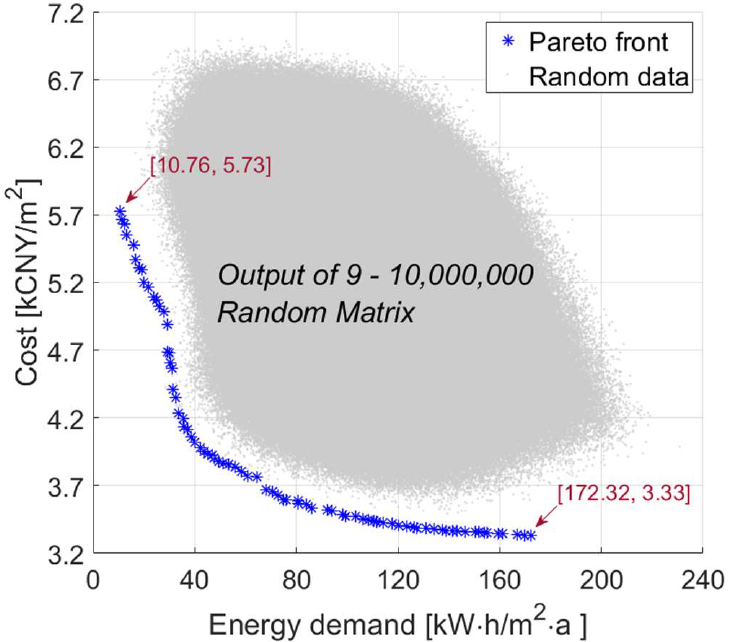
Figure 12. Pareto front generated by NSGA-III dual-objective optimization and target distribution generated by 9–10,000,000 random matrix.